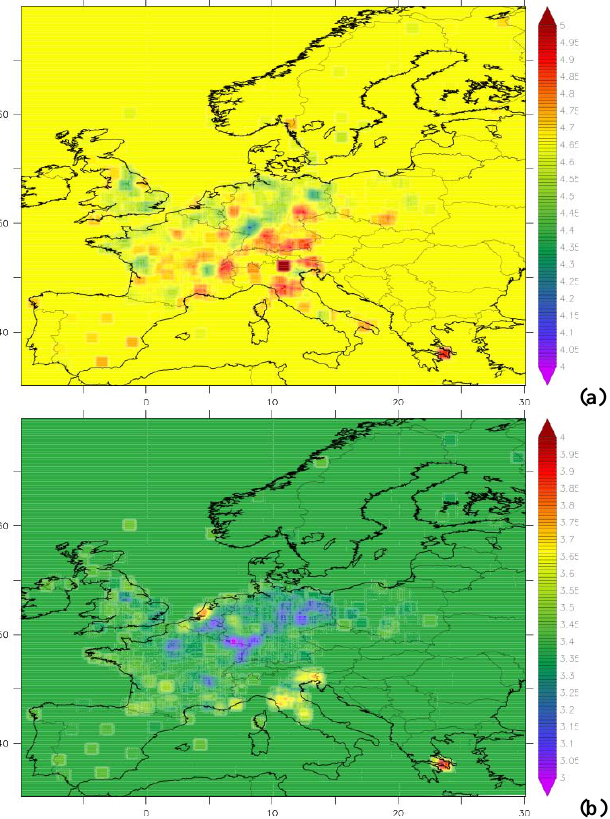
Fig. 3. Diagnosed length-scales (in km) of the horizontal correla- tion of the forecast error, averaged in the period between 1 and 10 July 2010: west–east (a) and north–south (b)